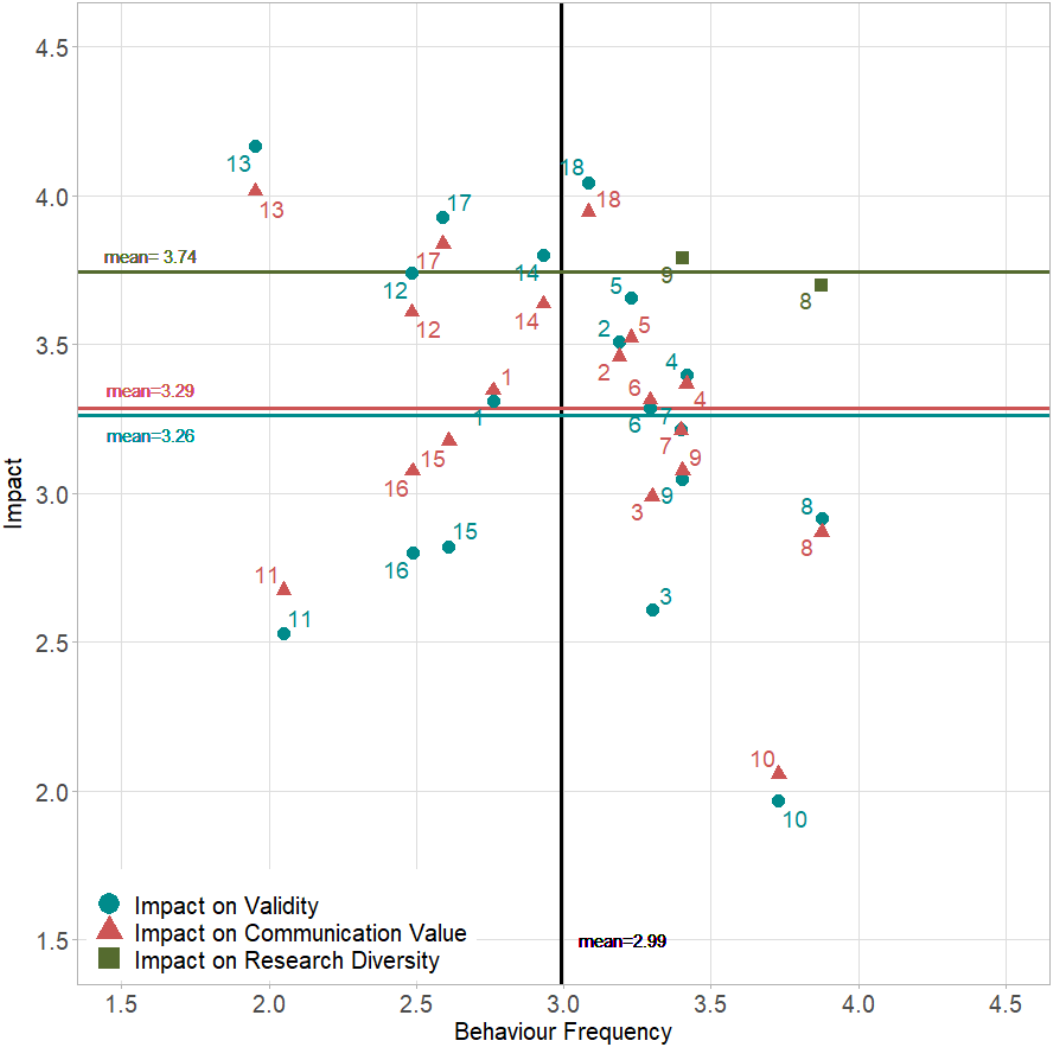
Figure 2. Impact on the three aspects of research quality for each type of misbehaviour versus the frequency of occurrence of each type of misbehaviour. Circles denote QC1, triangles refer to QC2 and the square to QC3. The four quadrants indicate high frequency and high impact (Q1), low frequency and low impact (Q3), low frequency and high impact (Q2) and high frequency and low impact (Q4).